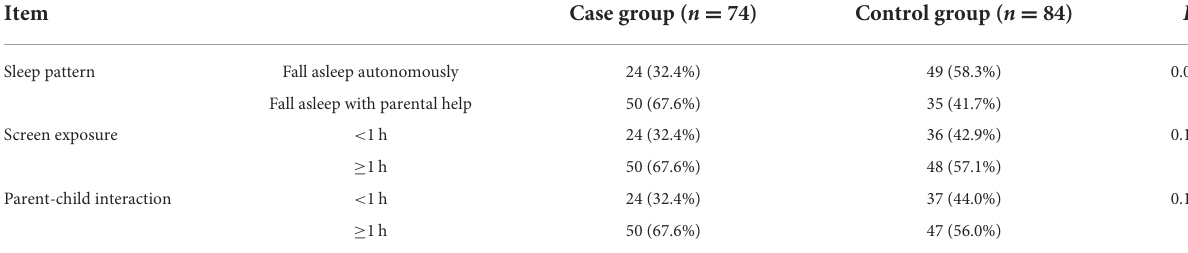
TABLE 4 Comparison of different sleep behaviors and screen exposure between case group and control